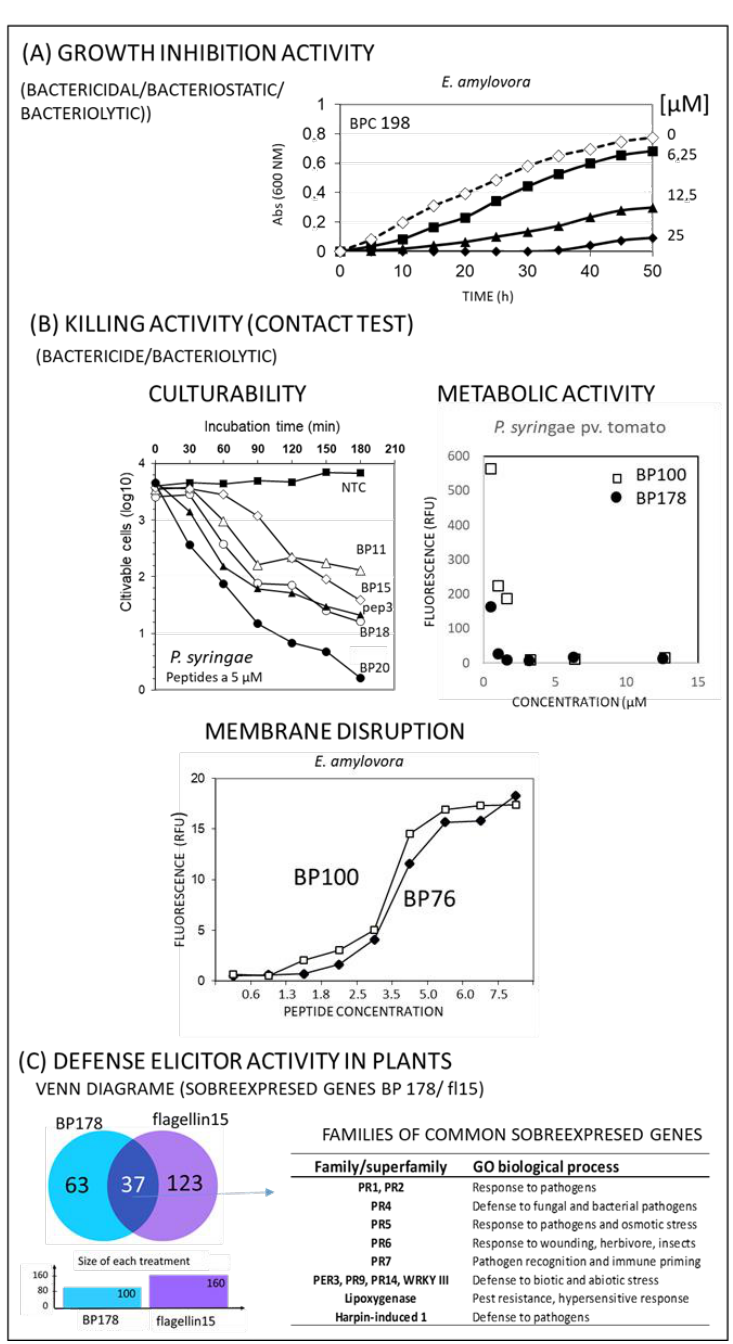
Figure 3. Examples of the results obtained for different peptides to determine their antibacterial activity and their defense elicitor activity in plants. ( A ) Results based on growth inhibition experiments (data from Monroc et al. [49]). ( B ) Results based on killing assays using contact tests (data from Ferre et al. and Montesinos et al. [10,36] and non-published results). ( C ) Venn diagram of the overexpressed genes in tomato plants after treatment with BP178 and flg15 using microarray analysis, showing 37 common overexpressed genes, and the table shows the family of common overexpressed genes and their Gene Ontology biological process (data from Montesinos et al. [10]).